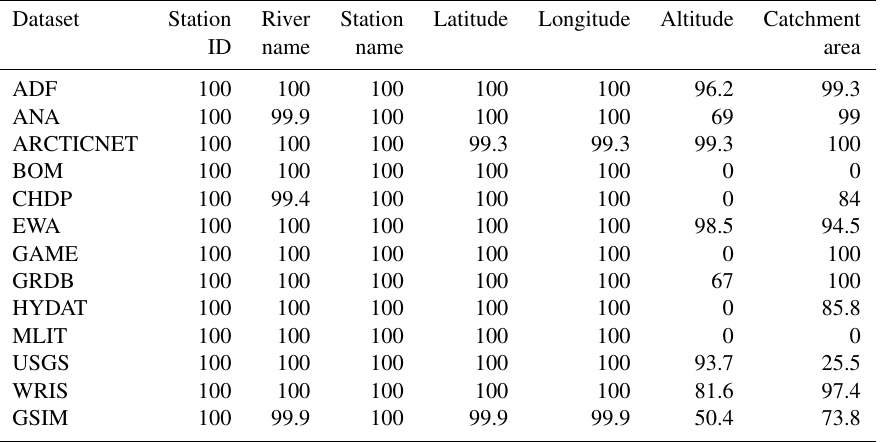
Table 7. The percentage of stations accompanied by all basic metadata.